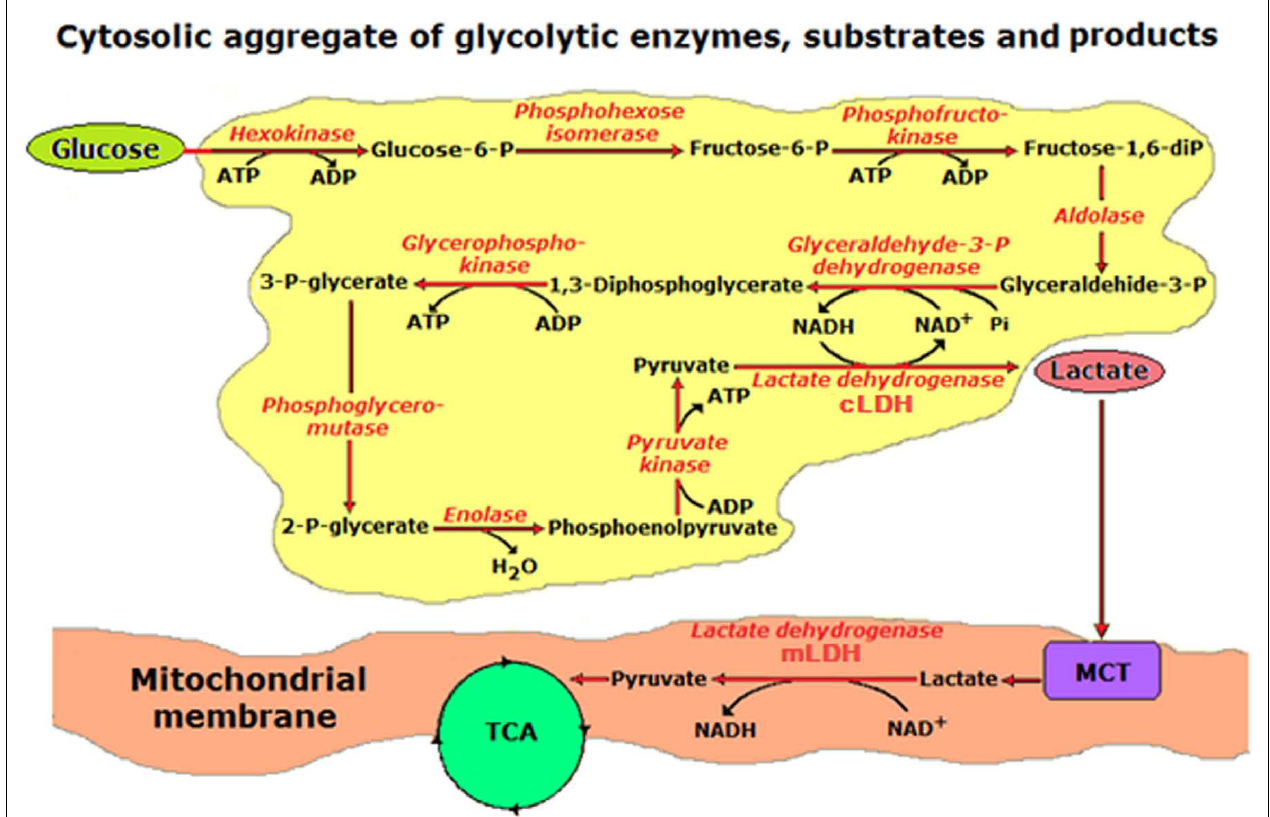
required by such a pathway for a maximized efficient output, with the entry of glucose into this pathway on the upper left side and an exit of lactate from the pathway on the right side through the action of cytosolic lactate dehydrogenase (cLDH). Lactate is shuttled via an intracellular shuttle to the mitochondrial membrane, where it is converted back into pyruvate via mitochondrial lactate dehydrogenase (mLDH) and into the tricarboxylic acid (TCA)